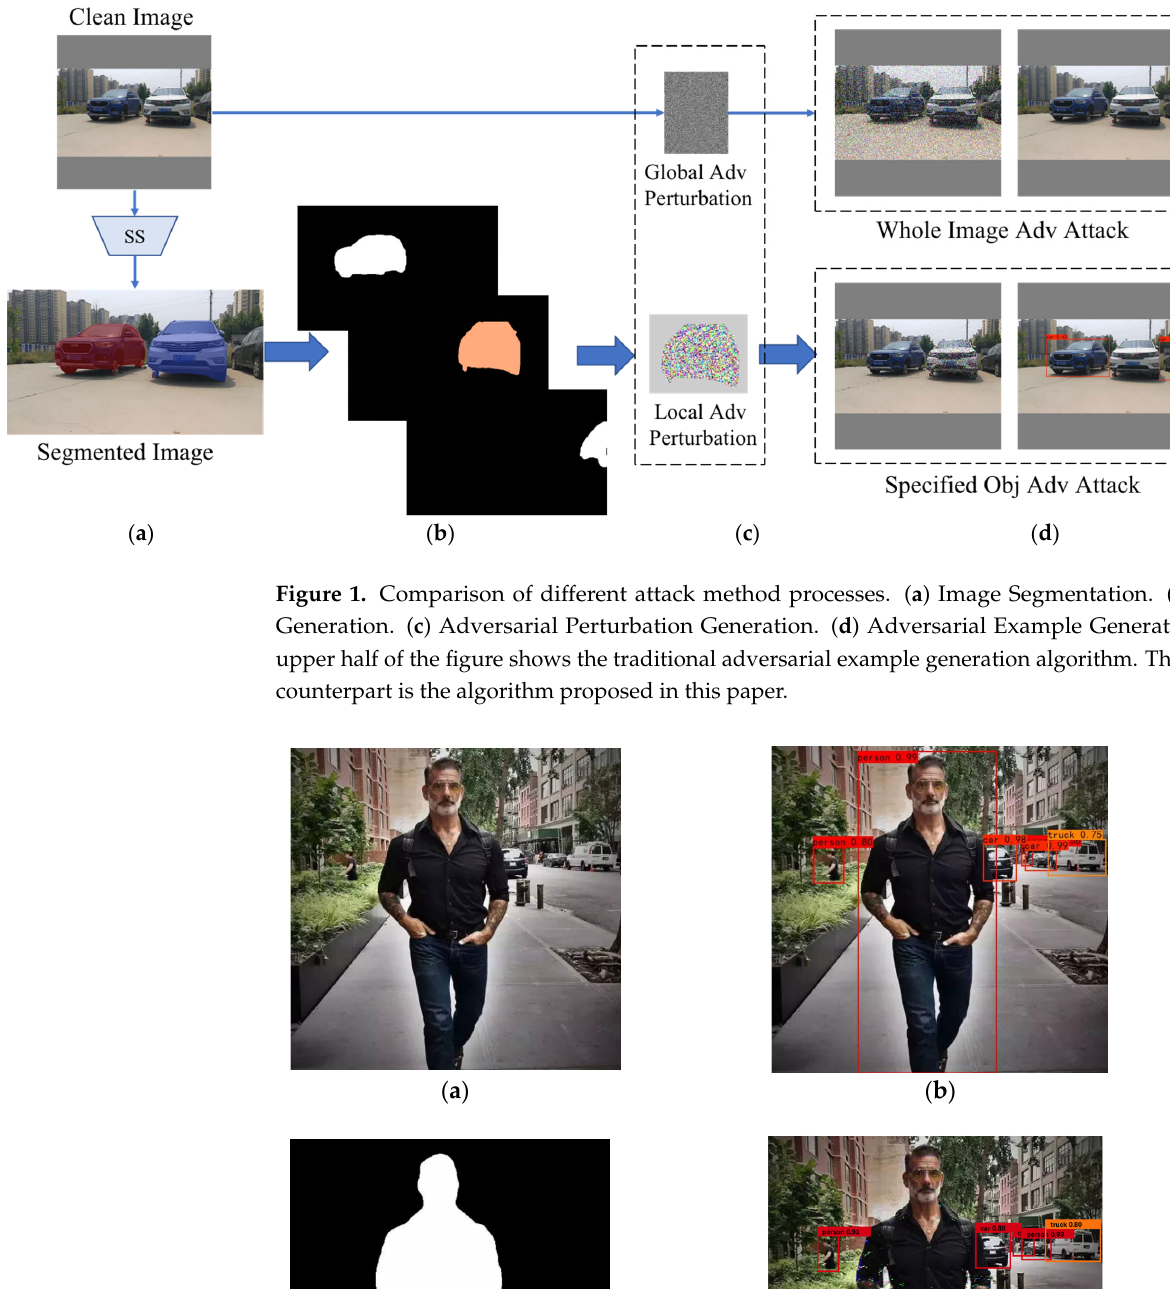
Figure 1. Comparison of different attack method processes. ( a ) Image Segmentation. ( b ) Mask Gen ‐ eration. ( c ) Adversarial Perturbation Generation. ( d ) Adversarial Example Generation. The upper half of the figure shows the traditional adversarial example generation algorithm. The bottom coun ‐ terpart is the algorithm proposed in this paper.